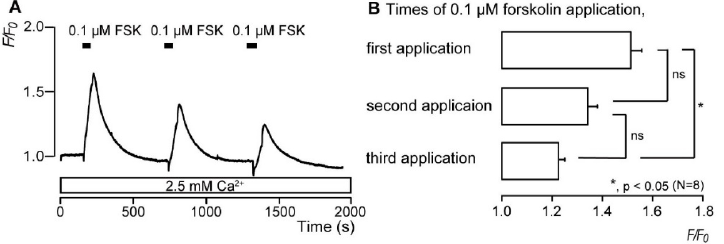
Figure 3. Repeated application of forskolin elicits a desensitizing effect on the intracellular cAMP level ([cAMP] i ). ( A ) Representative trace of the transient increases in [cAMP] i during the administration of 0.1 μM forskolin (FSK) in standard extracellular solution with 2.5 mM extracellular Ca 2+ (white box at the bottom). Black boxes indicate the time periods of FSK addition to the standard extracellular solution. ( B ) Summary bar graph represents values of F/F 0 for the increases in [cAMP ] i after first (upper), second (middle), and third (lower) applications of 0.1 μM FSK. Each bar denotes the mean ± SE of 8 experiments. Asterisks denote statistically significant differences between columns (shown by solid lines): * p < 0.05.